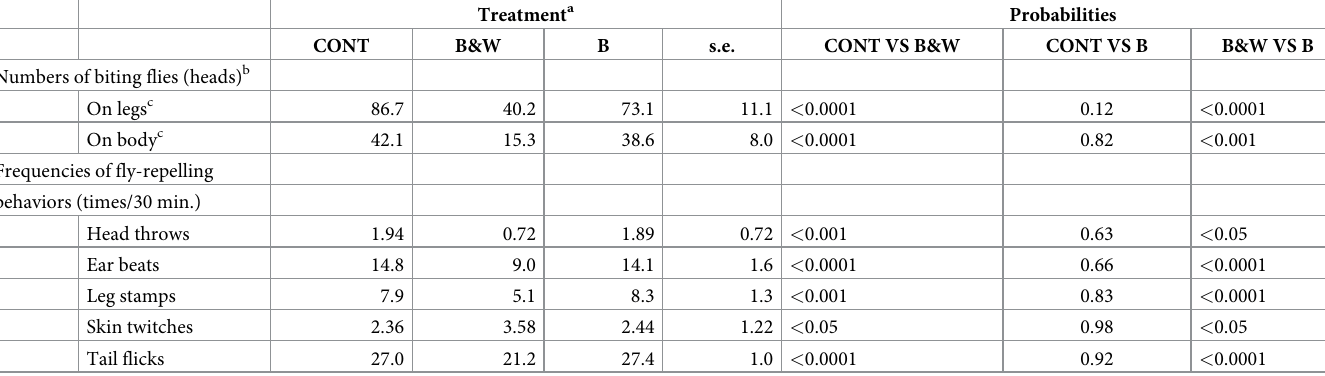
Table 1. Numbers of biting flies on the experimental cows and the frequencies of fly-repelling behaviors.